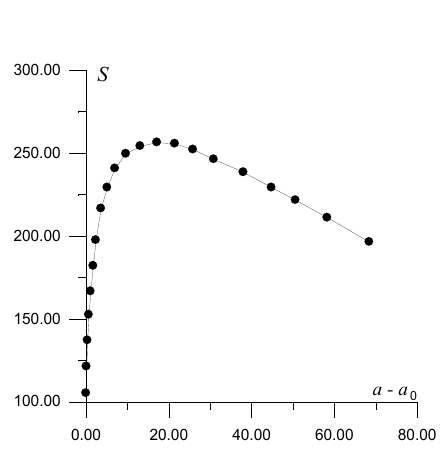
Figure 9: Experimental stress vs. crack length